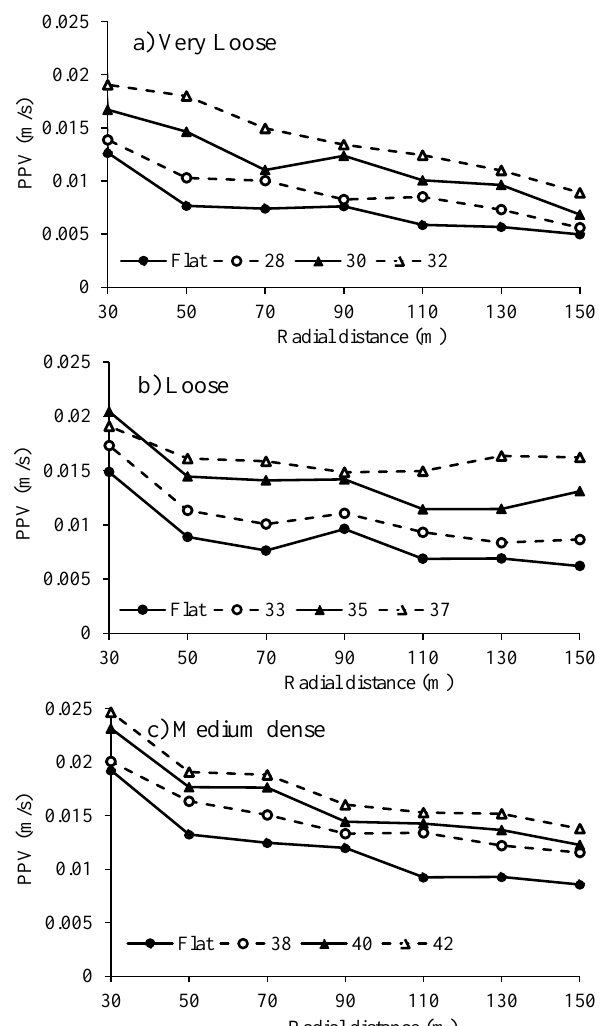
Fig. 10. Variation of PPV in 5 th blow count with radial distance from tamper centerline for various cone angles and different soil